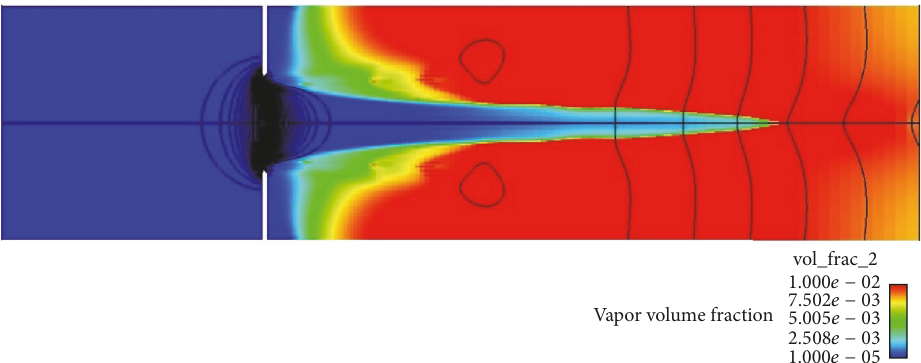
Figure 68: Lady 21 test: two-dimensional representation of the pressure and void fraction calculated by the CFD code (see Figure 67).